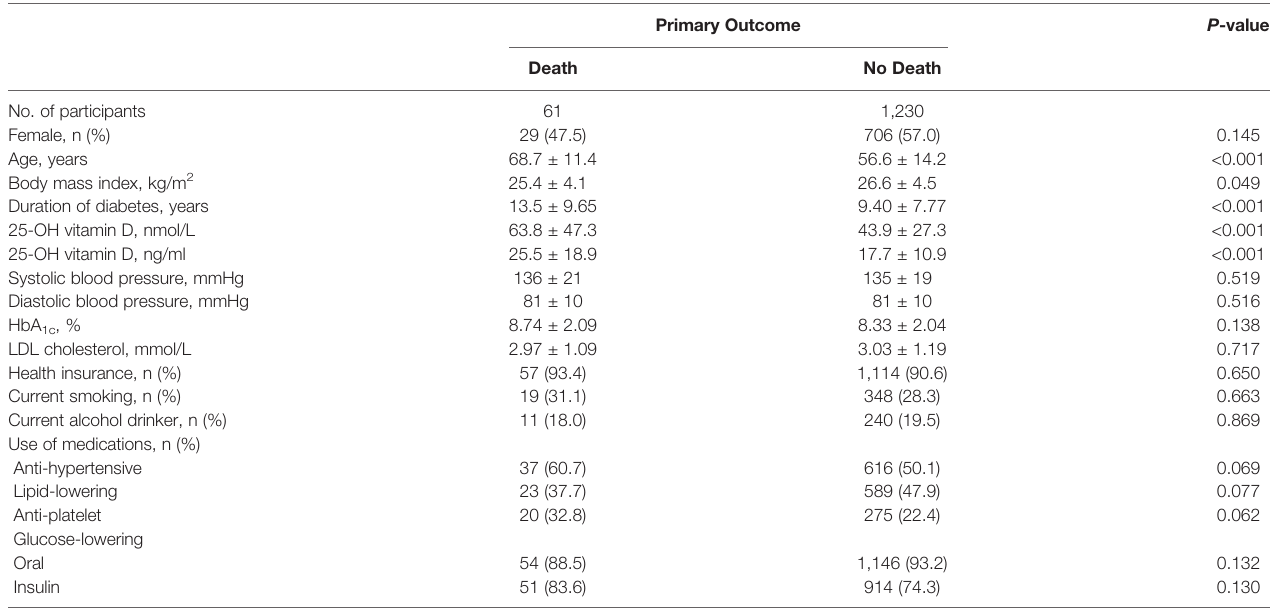
TABLE 2 | Baseline characteristics of the study participants according to primary